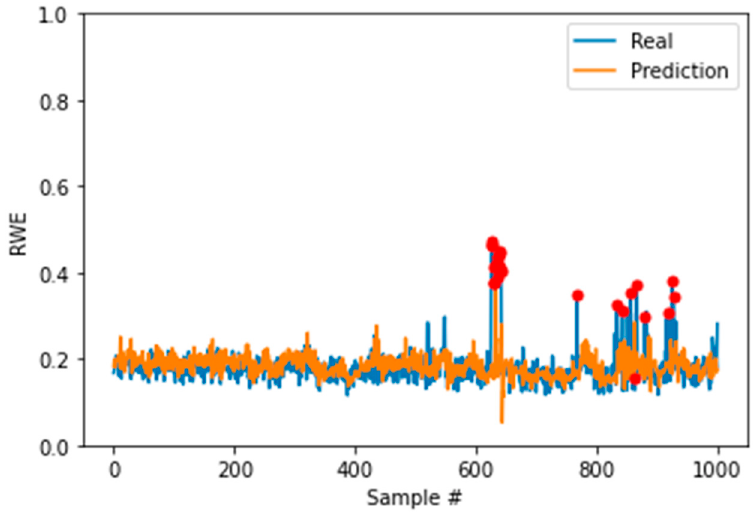
Figure 10. Anomaly detection results of the RWE–LSTM model (red dots mark the anomalies).